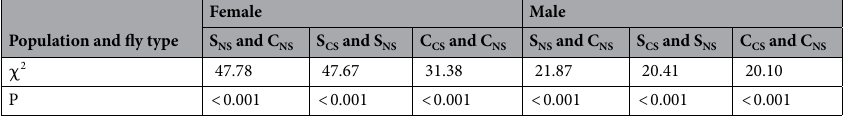
Table 1. Comparison of age dependent survival of males and females under selection for faster pre-adult development and extended longevity, and larval diet curtailing at critical